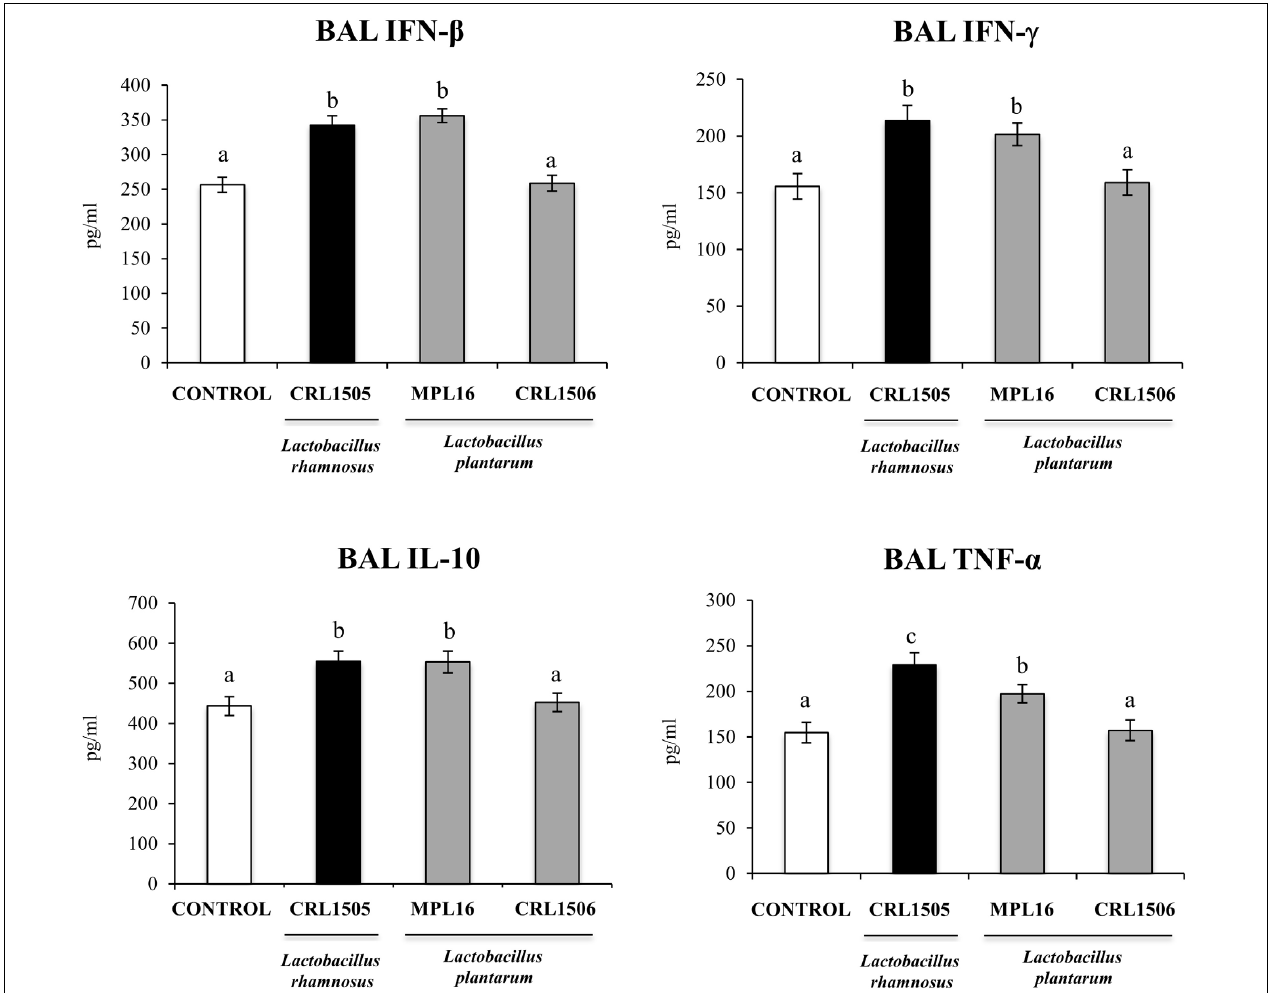
FIGURE 11 | Levels of bronchoalveolar lavage (BAL) interferons (IFN- β and IFN- γ ), TNF- α , and interleukin 10 (IL-10) in mice orally treated with Lactobacillus rhamnosus CRL1505, Lactobacillus plantarum CRL1506, or L. plantarum MPL16 (10 8 cells/mouse per day for five consecutive days) and then challenged by the nasal route with RSV. Mice with no lactobacilli treatment and infected with RSV were used as controls. Immune markers were evaluated on day 2 after viral infection. The results represent data from three independent experiments ( n = 6 per group). Letters indicate significant differences ( P < 0.05), a < b < c.